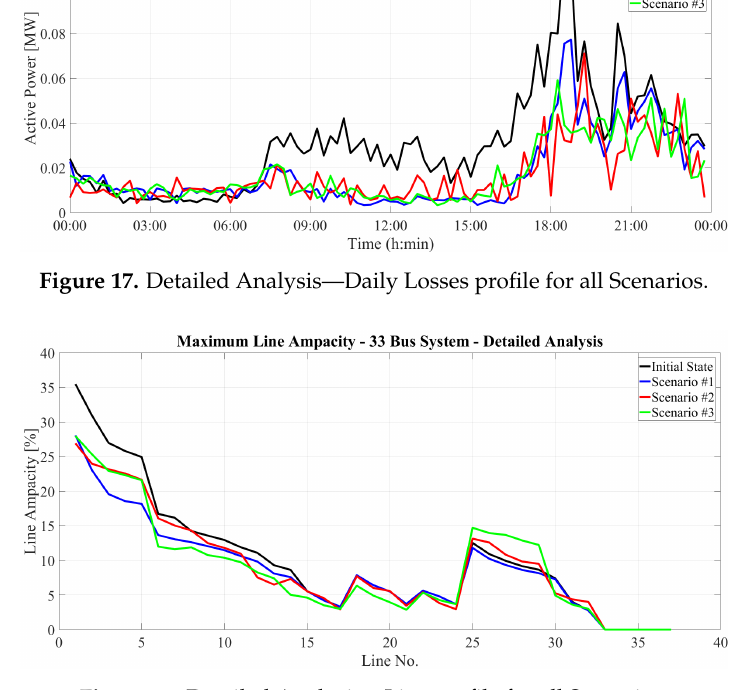
Figure 18. Detailed Analysis—Line profile for all